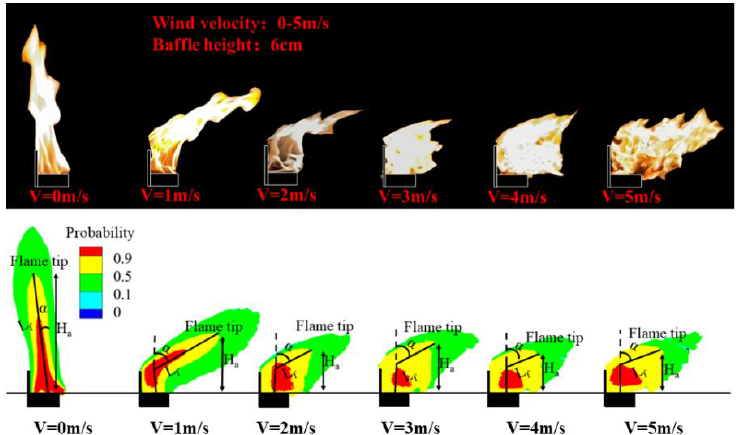
Figure 8. Flame characteristics under a 0–5 m/s wind velocity and a 6 cm-high baffle.